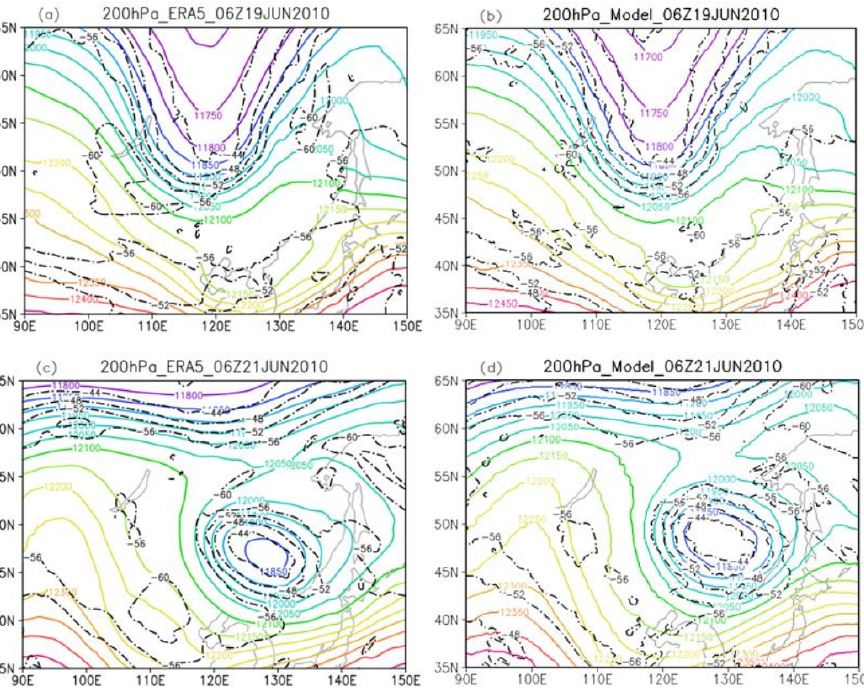
Figure A3. The 200 hPa geopotential height (solid lines, unit: gpm) and temperature (dash–dot lines, unit: ◦ C) from the ERA5 data ( a , c ) and the simulation ( b , d ), at 06:00 UTC on 19 June, and at 06:00 UTC on 21 June,